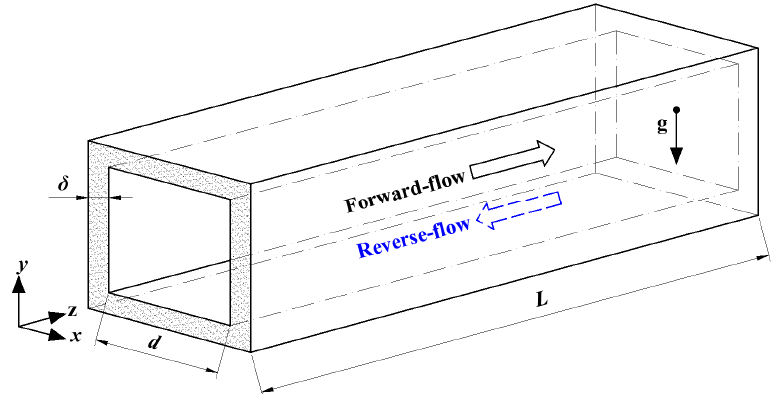
Figure 1. Physical model of the honeycomb ceramic conduit.